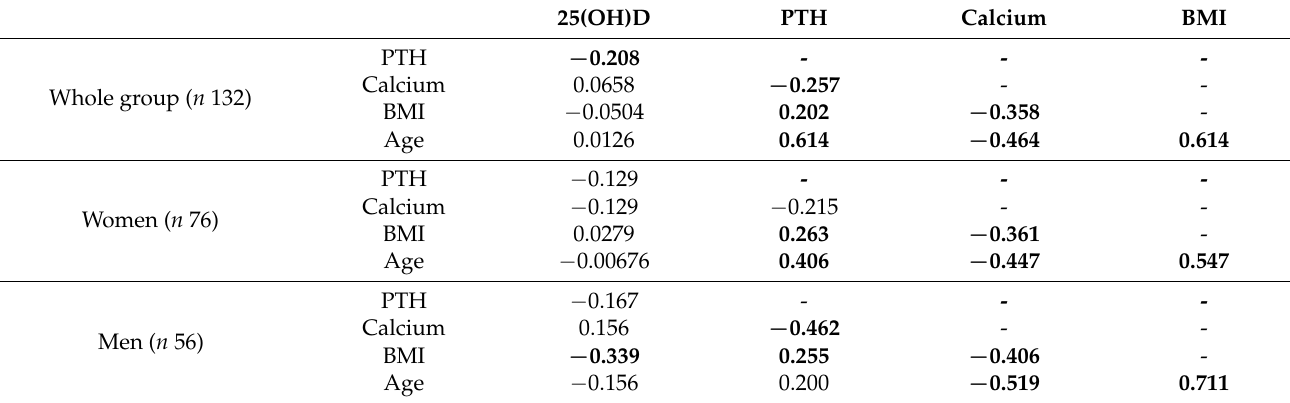
Table 2. Correlation analysis of the measured parameters (Spearman rank method), for all subjects, for women and men. Statistically significant ( p < 0.05) variables are highlighted in bold